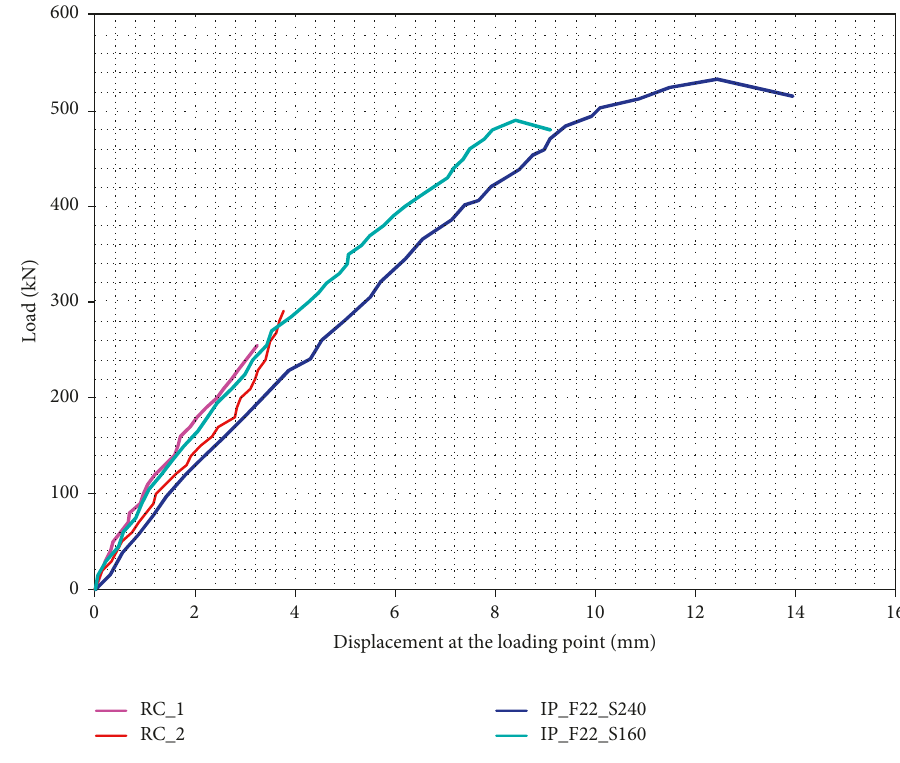
Figure 4: Load–displacement curve of specimens. Table 3: Main experimental results of specimens.